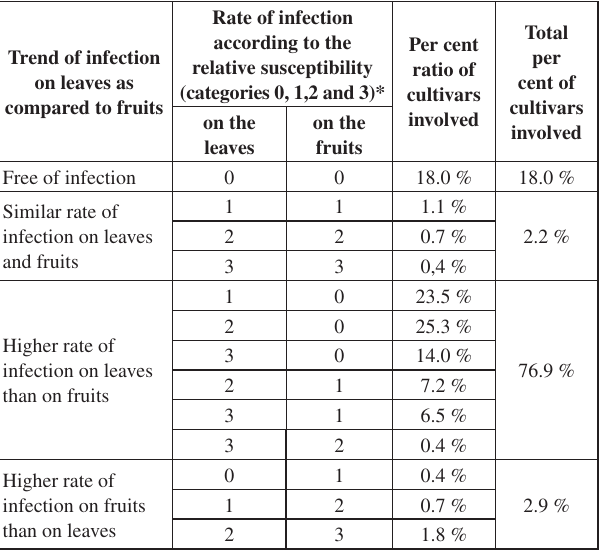
Higher rate of infection on leaves than on fruits